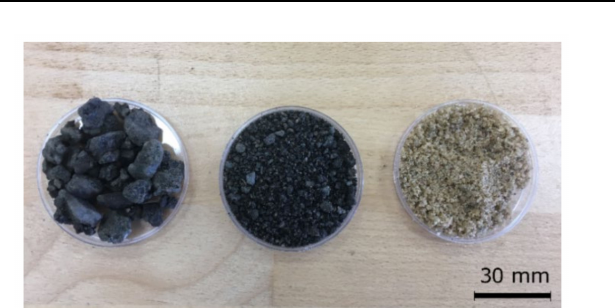
Figure 1. Samples of silica aggregate and RAP aggregate after separation of coarse